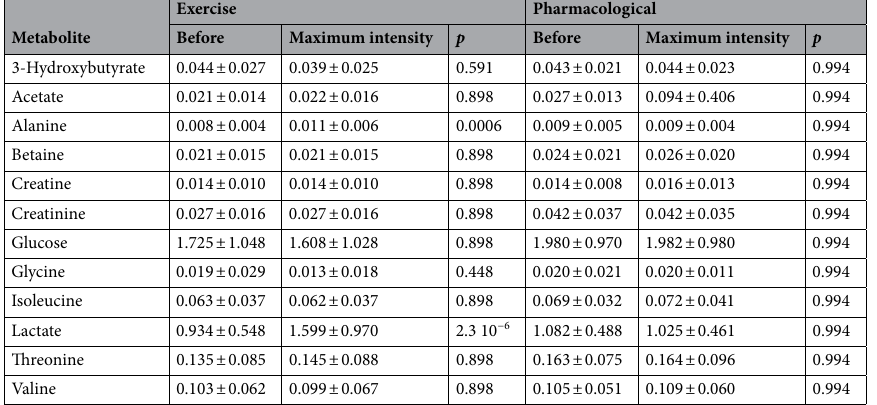
Table 4. Serum metabolite concentration (mmol/L) according to the type of exercise; measured before and at the time of maximum intensity. P values were corrected for multiple comparisons.